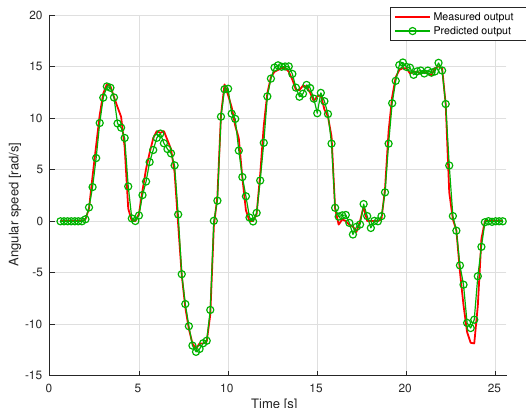
Figure 5. Comparison between measured output (red line) and GP model predicted output (green line).